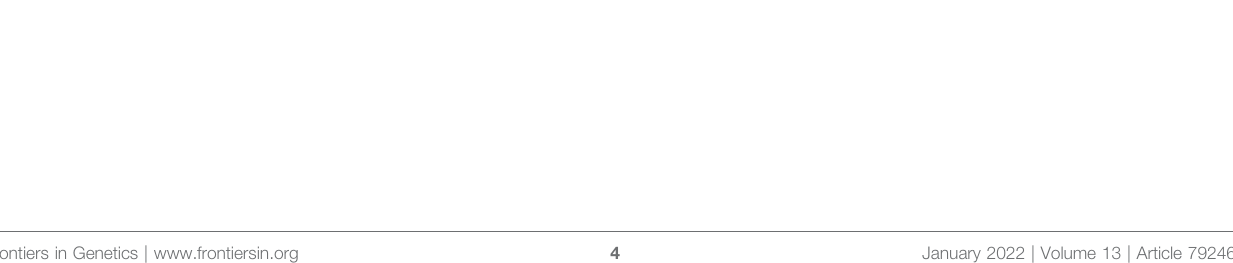
Frontiers in Genetics |